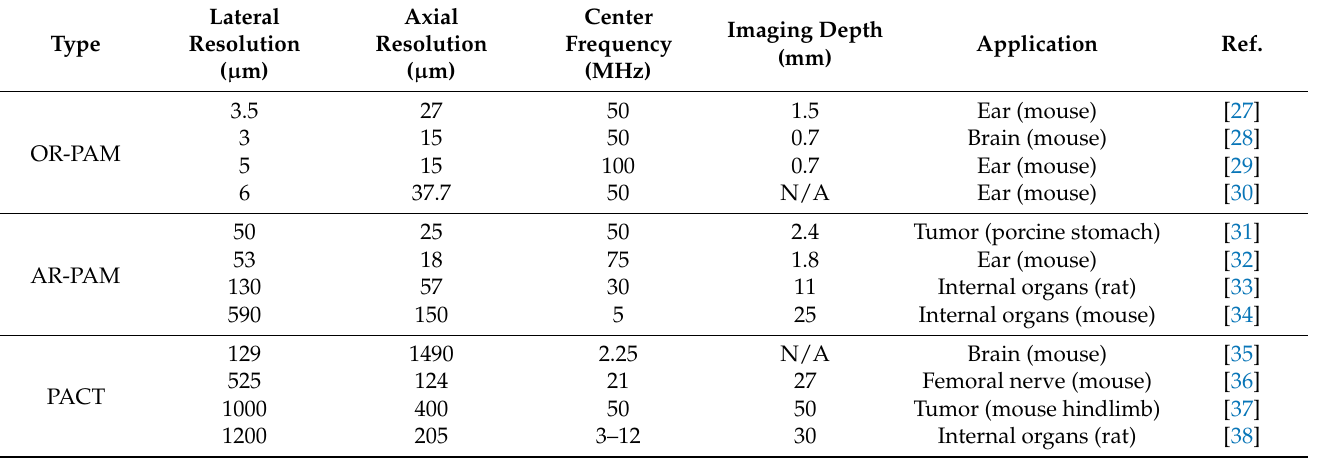
Table 1. Performance benchmarks of representative results of OR-PAM, AR-PAM, and PACT. OR- PAM, optical-resolution photoacoustic microscopy; AR-PAM, acoustic-resolution photoacoustic microscopy; PACT, photoacoustic computed tomography; N/A, not available.